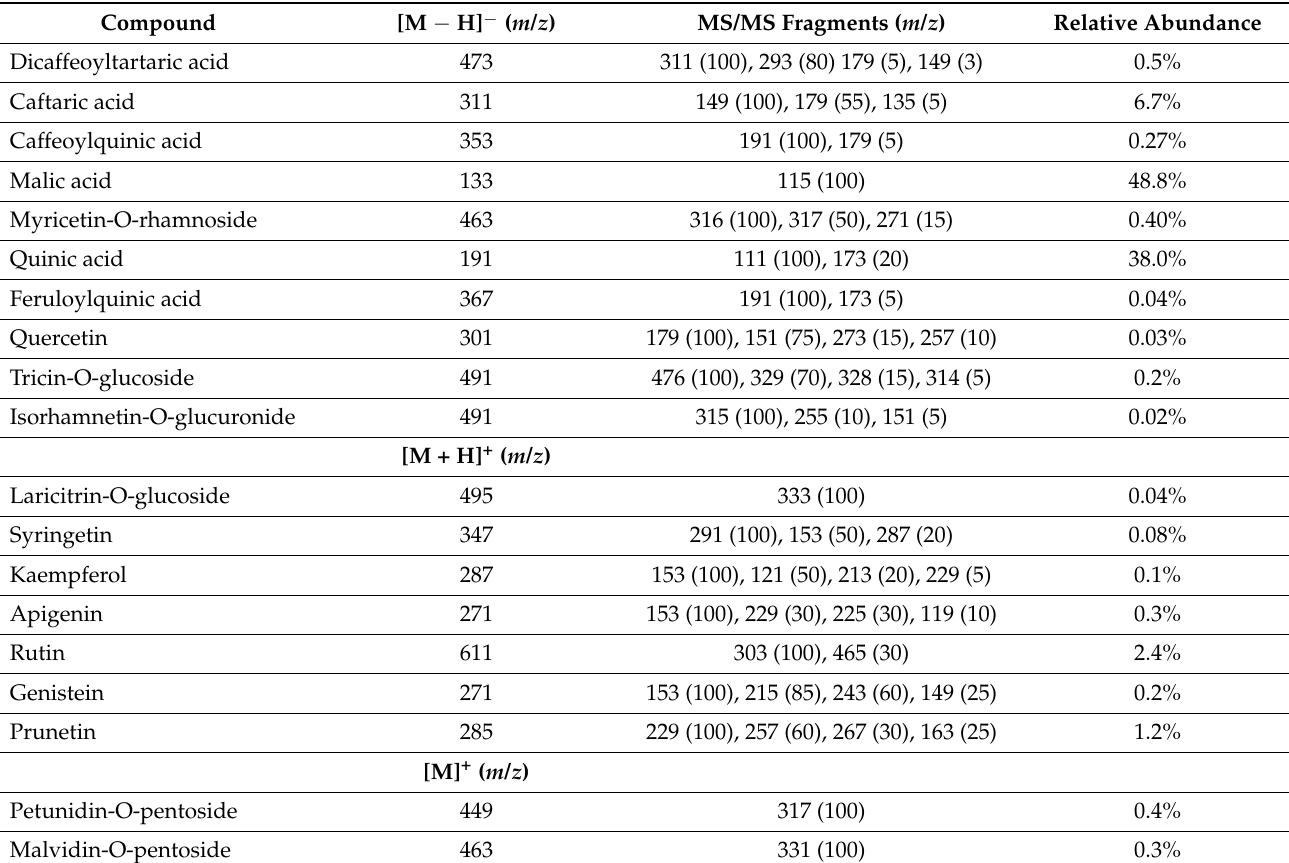
Table 3. Tentative LC-MS/MS identification of most abundant compounds in asparagus hard